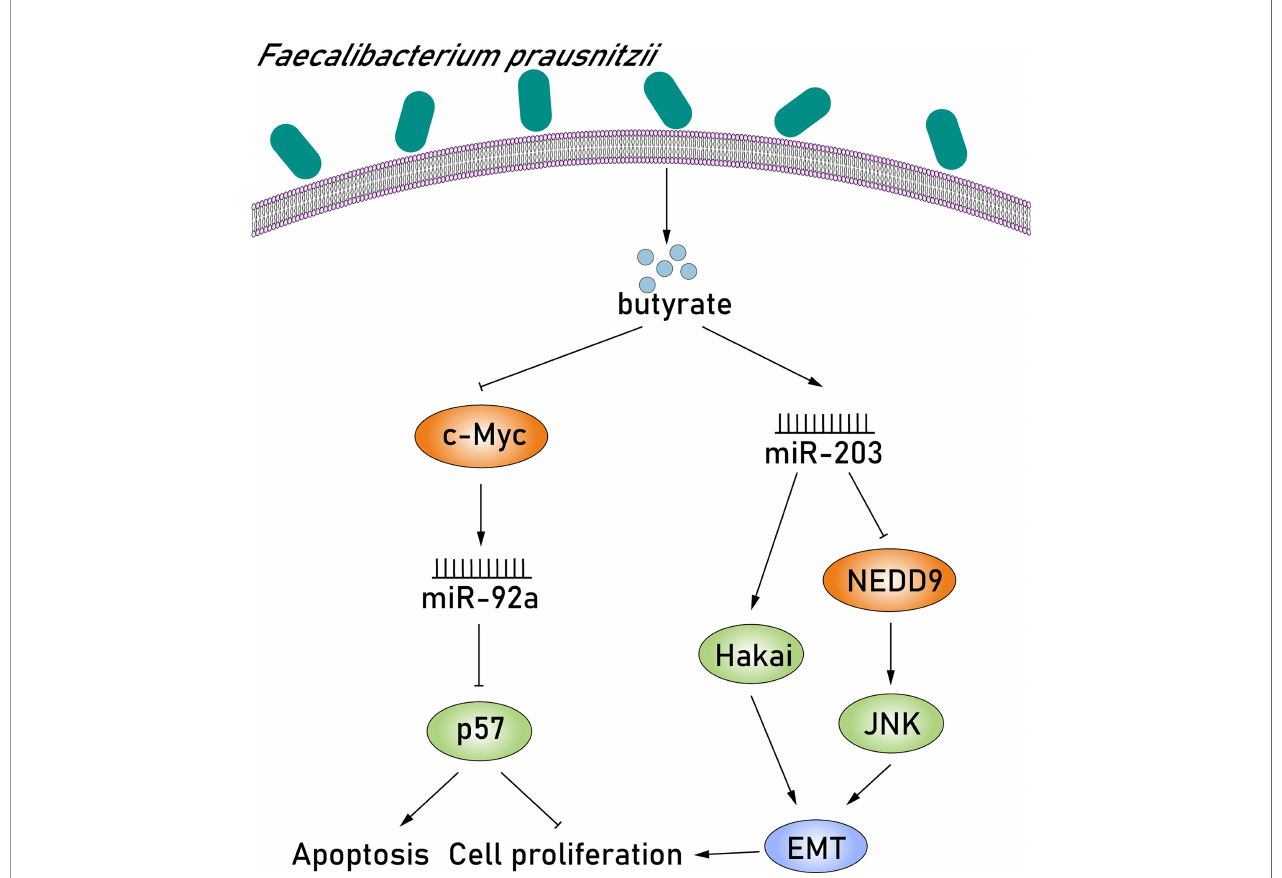
FIGURE 5 | Butyrate produced by F. prausnitzii suppresses the proliferation of CRC cells by modulating miR-92a and miR-203. First, butyrate produced by F. prausnitzii suppressed oncogenic miR-92a overexpression in human CRC cells and detected a rapid decrease in the levels of c-MYC after butyrate treatment. miR- 92a downregulation subsequently stimulated p57 expression, which is epigenetically silenced in cancer, blocks cell proliferation by promoting apoptosis, inhibiting angiogenesis and cell cycle arrest. In contrast, miR-203 expression is upregulated after butyrate treatment and consequently suppresses the proliferation of CRC cells via directly inhibiting NEDD9 expression. NEDD9, a signi fi cant tumor-promoting factor, can induce the EMT by activating JNK, thereby promoting tumor invasion and metastasis. Upregulated miR-203 induced by butyrate can also lower Hakai expression, eventually suppressing the proliferation of CRC